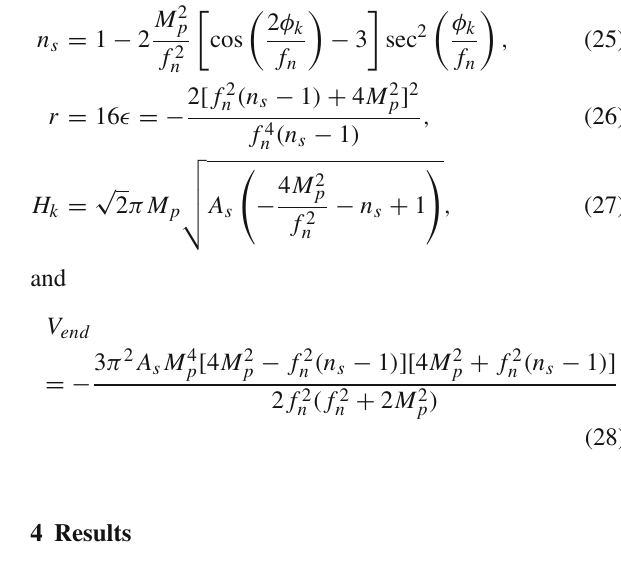
different e-folding numbers, which N k = 55 and N k = 65 correspond to up and down lines, respectively. The Gradient graphindicatesthevalueofdecayconstantvaryingfrom1 M p to 30 M p . The light blue and light grey shaded broadband stand for the latest experiments with 1 σ and 2 σ experiment errors of BAO, BICEP/KECK, and Planck data, respectively